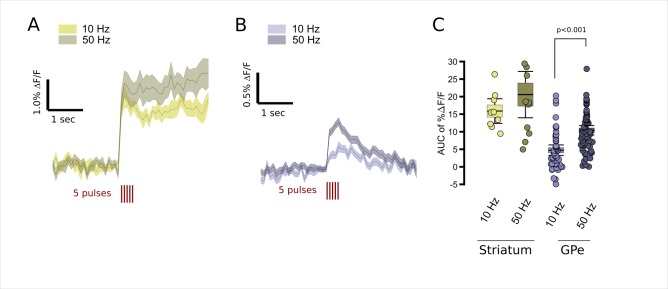
Modulation of FFN102 transients by stimulus frequency.(A) FFN transients evoked in the striatum by five pulses (red lines) at 10 Hz, gold traces, or 50 Hz, dark gray traces (N = 9 slices for 10 Hz stimuli, N = 12 slices for 50 Hz stimuli; shading represents SEM). (B) FFN transients evoked in the GPe by five pulses at either 10 Hz, bright blue traces, or 50 Hz, dark blue traces (N = 52 slices for 10 Hz stimulation, N = 68 slices for 50 Hz stimulation). (C) The AUC %ΔF/F for the period from 0 to 300 ms from stimulus onset. Striatal responses were not significantly different at higher frequencies (CI95 of %ΔF/F at 10 Hz = [12.6,19.1] versus at 50 Hz = [14.7,26.5]), whereas GPe showed significantly higher AUC %ΔF/F at 50 Hz than 10 Hz (CI95 of %ΔF/F at 10 Hz = [3.46, 5.99] versus at 50 Hz = [9.28, 11.5]), significance assessed using two-tailed unpaired t-test, p < 0.001).10.7554/eLife.42383.009Figure 5—source data 1.Fluorescence time courses for FFN transients evoked by 10 Hz and 50 Hz stimulation.10.7554/eLife.42383.010Figure 5—source code 1.Analysis and figures for FFN102 transients evoked by 10 Hz and 50 Hz stimulation.